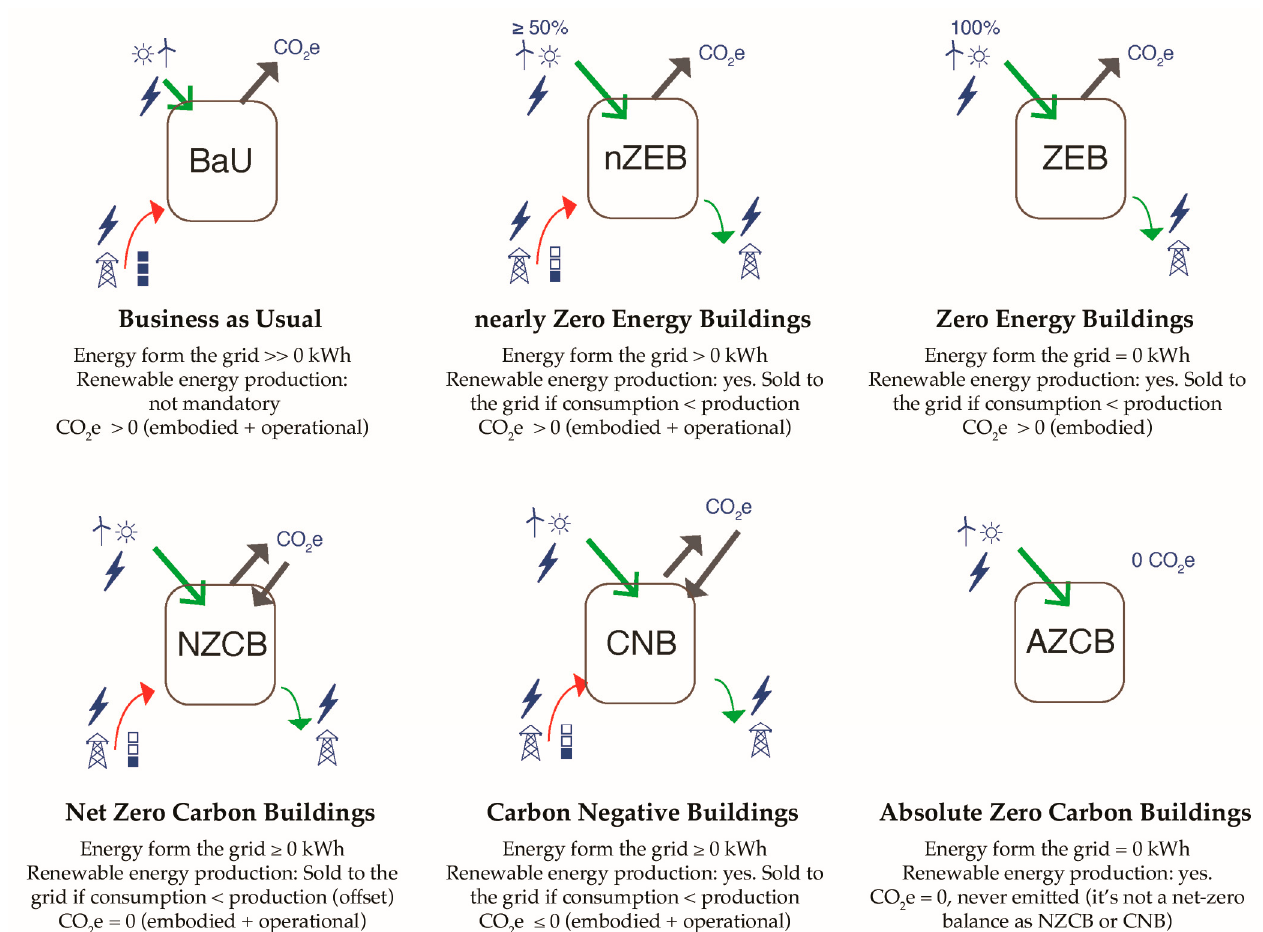
Figure 1. Different classifications for buildings based on energy consumption from the grid, renew- energy production, carbon emission production and able energy production, carbon emission production and offset.